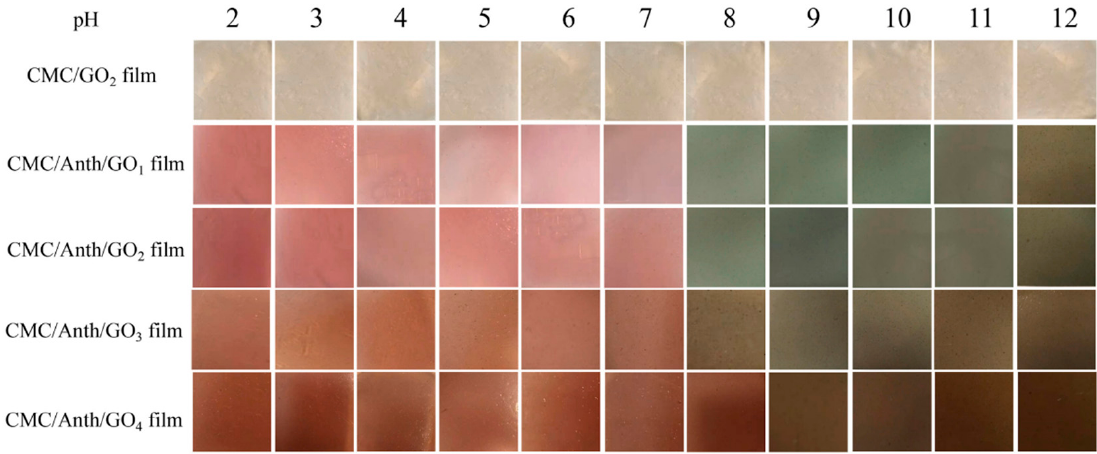
Figure 5. The colour response of films to different pH buffer solutions after soaking for 1 min (taken from [73]).